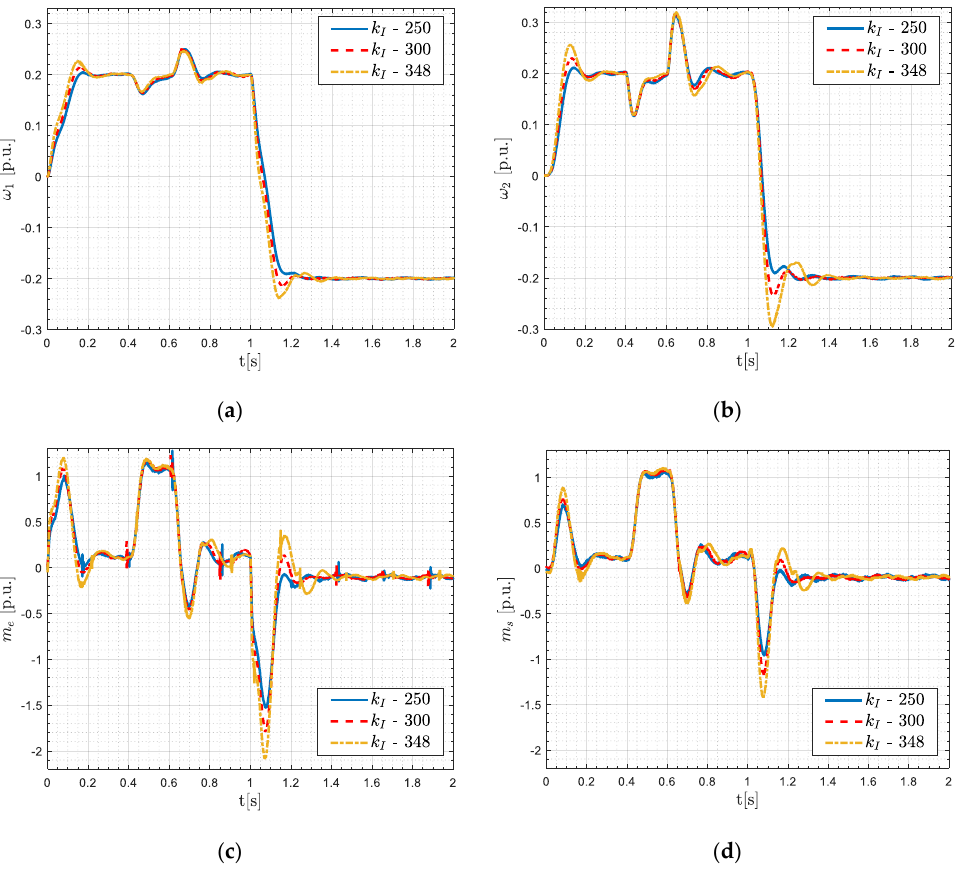
Figure 12. Experimental transients of the two-mass system: motor speed ( a ), load speed ( b ), electromagnetic torque, ( c ) and shaft torque ( d ) for di ff erent gains of the speed controller and value of the reference signal equal to 0.2 for R =